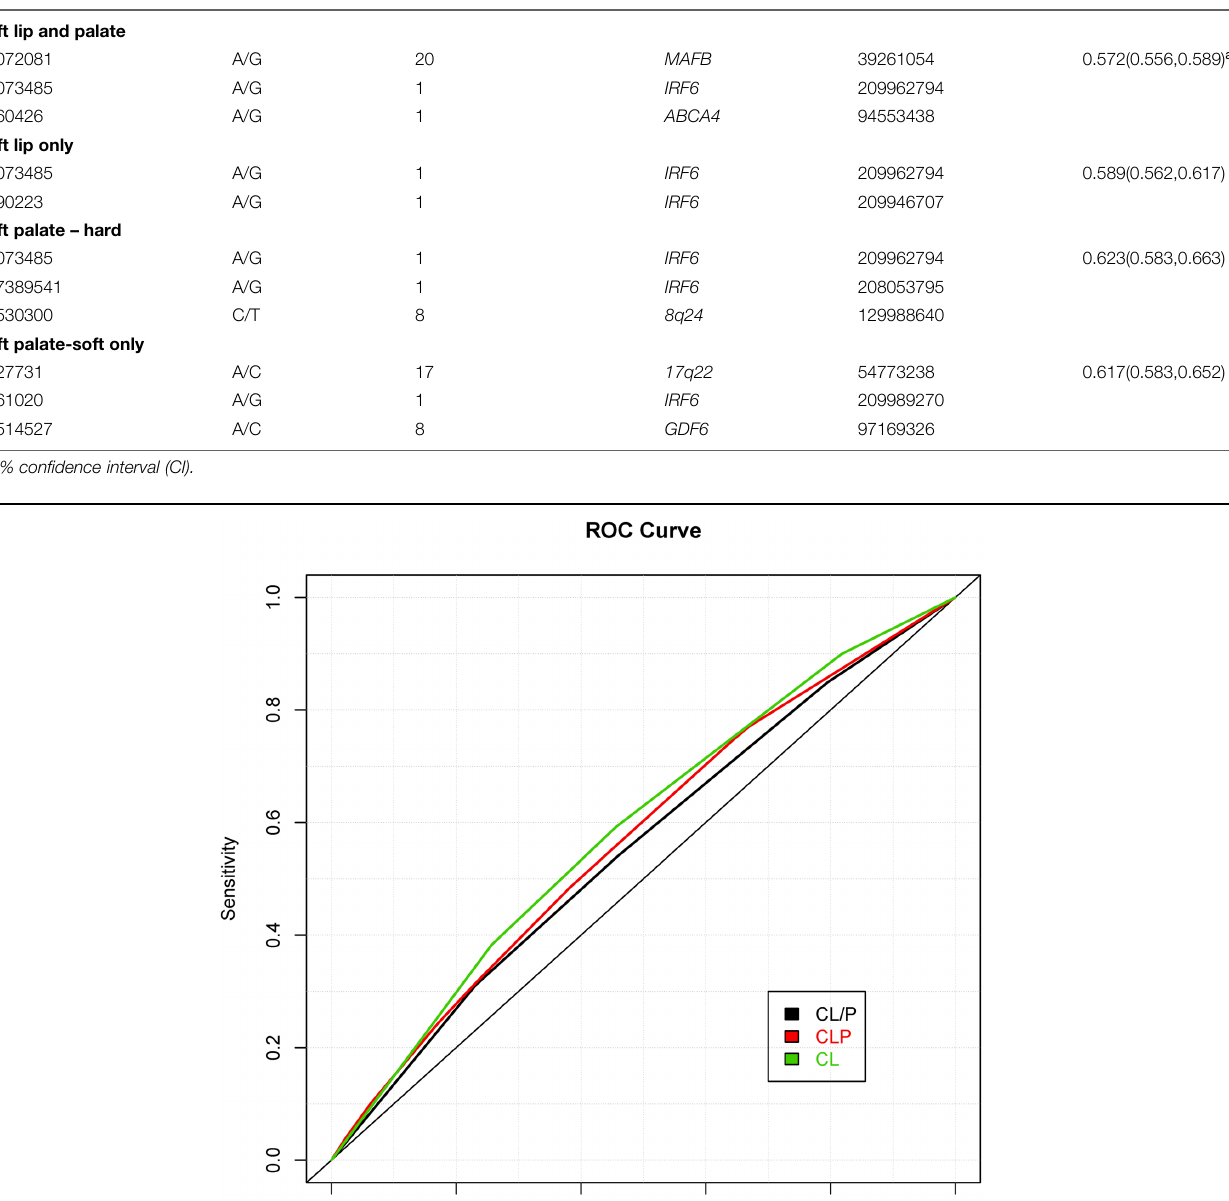
one group by the MLRE method. The area under the ROC curve (AUC) of the CLP risk prediction model, which comprised of rs6072081 ( MAFB ), rs2073485 ( IRF6 ) and rs560426 ( ABCA4 ), was estimated to be 0.572 with 95% confidence interval (CI) of (0.556, 0.589). Left CL and right CL were also treated as